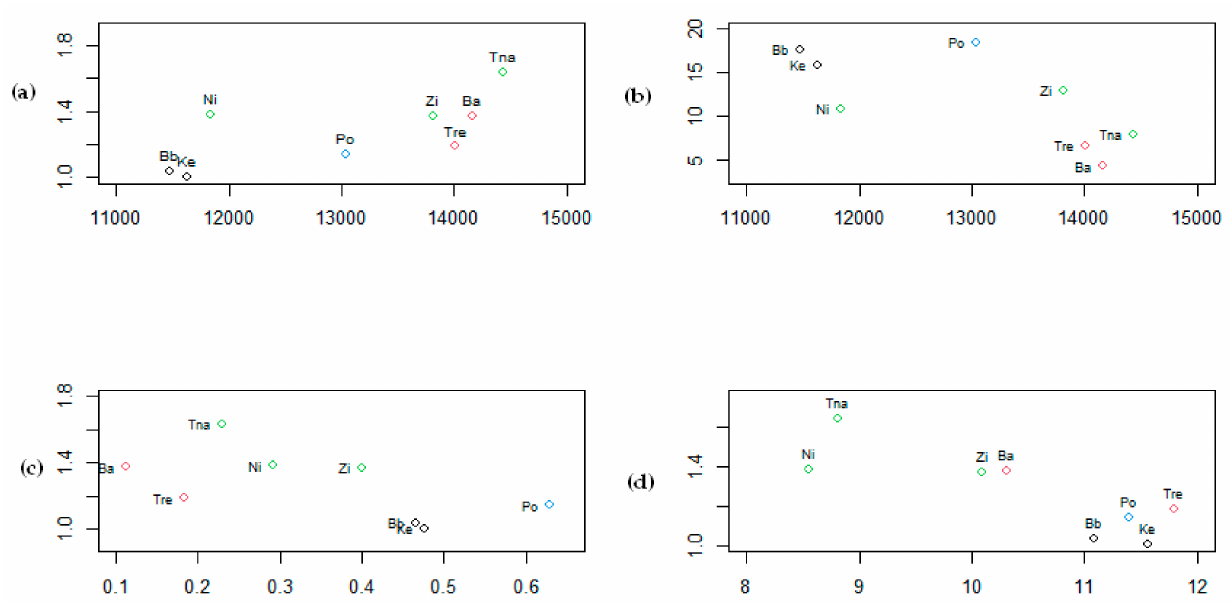
Figure 13. Comparison of indexes after clustering for 2018: ( a ) Communal waste per household in t per year according to net expenses of household in ( € ); ( b ) measure of poverty risk—60% of median at percentage (%) according to net expenses of household in € ; ( c ) communal waste per household in t per year according people below the poverty line per 1 household; ( d ) communal waste per household in t per year according to waste costs in € with relation to kg.